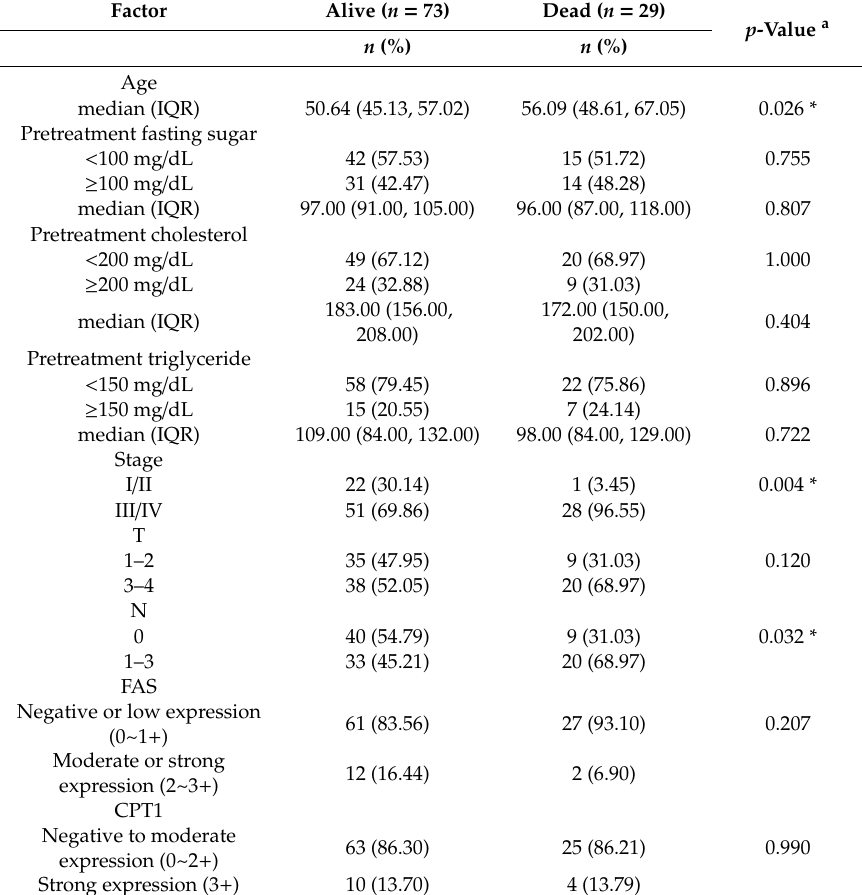
Table 2. Correlations between the survival status and patients’ characteristics ( n =